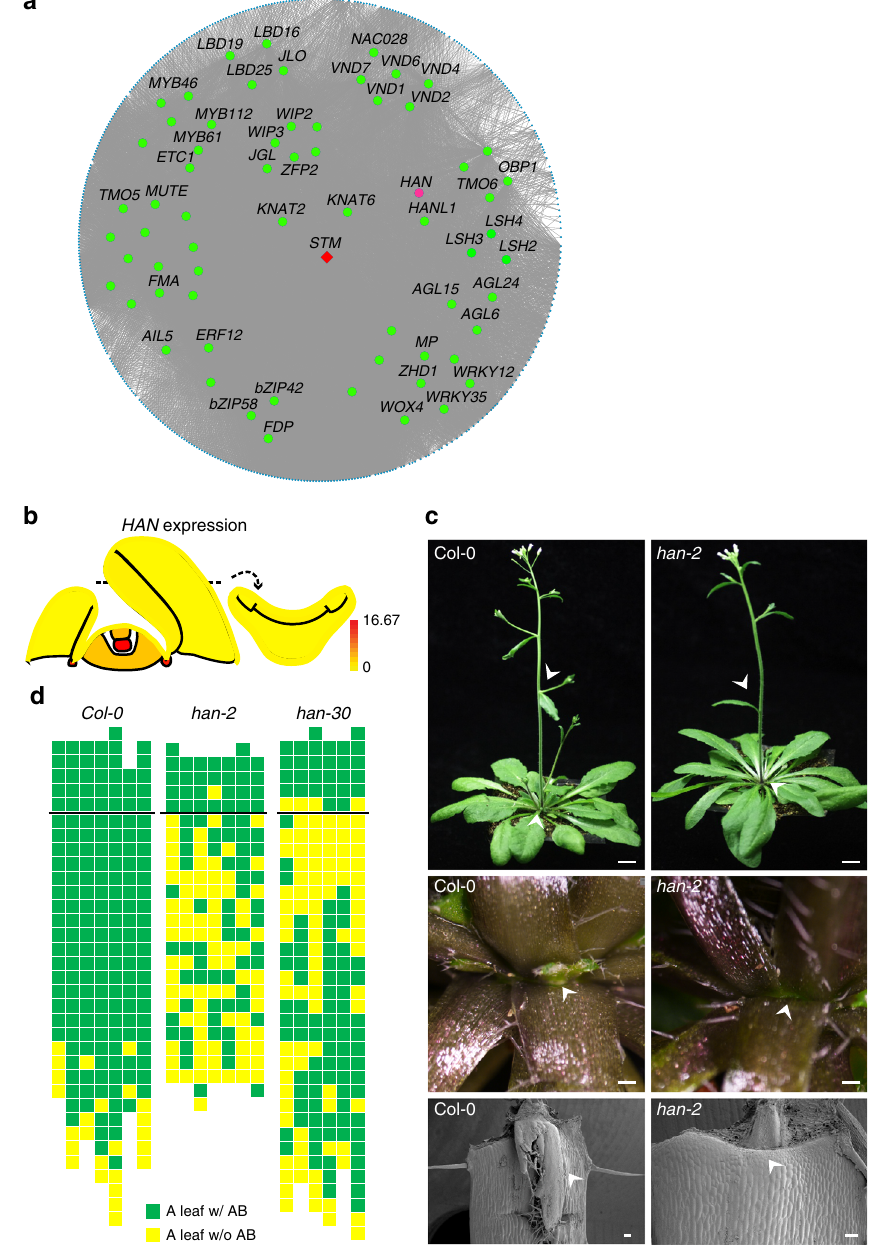
Fig. 5 GCN module M5 and function of HAN in AM initiation. a Module M5 displayed by Cytoscape as in Fig. 4b. Transcription factors are in the middle, with known AM regulators in red, HAN in purple, and others in green. b Expression pattern of HAN viewed by the eFP browser. c AM defects in han-2 mutants. The whole plant (upper panel, scale bar = 1 cm), close-up of rosette leaf axils (middle panel, scale bar = 500 μ m), and also scanning electron microscope view (lower panel, scale bar = 100 μ m) in Col-0 and han-2 mutant plants showing the presence and absence of AMs (arrowhead), respectively. d Schematic representation of axillary bud formation in leaf axils of wide-type and mutant plants. Each column represents a single plant, and each square within a column represents an individual leaf axil. The horizontal line indicates a border between cauline leaf and rosette leaf, with the youngest to oldest from above to bottom. Green or yellow color indicates the presence or absence of an axillary bud in the particular leaf axil, to Auxin Stimulus ” was enriched, consistent with the (Supplementary Fig. 12b). For example, RNAs associated with- known active auxin transport and distribution in the epidermis, Epidermis Cell Differentiation, Wax Biosynthesis, and Cell and this category included transcripts from AUX/IAA family Wall Organization were all signi fi cantly enriched in the genes (Supplementary Fig. 12c). In addition, we observed that epidermis, con fi rming known physiological functions. As RNAs of genes whose expression responds either positively or another example, genes encoding extensins and expansins were negatively to other hormone stimuli were enriched in the also enriched in the epidermis (Table 1), as might be expected if epidermis, suggesting that epidermal function involves active the expansion of epidermal cells controls that of inner cell hormonal signaling functions and integration (Supplementary layers 56,59 . In addition, genes involved in trichome and stoma formation are highly enriched (Table 2). Also, “ Response Fig. 12d).